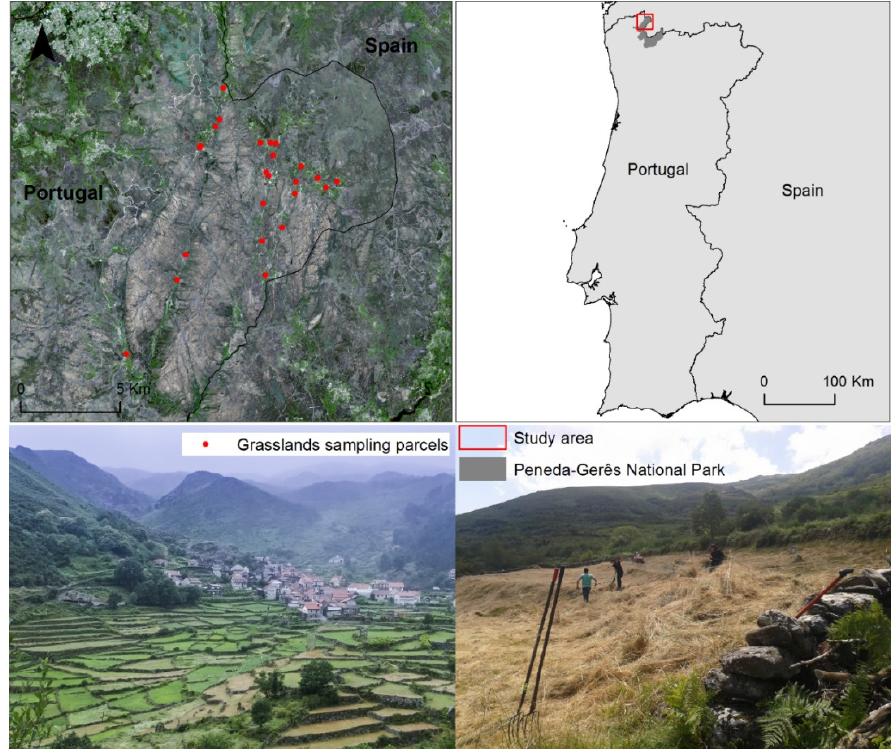
Figure 1. The study area located in the Portuguese Peneda − Gerês National Park, part of the trans- boundary biosphere reserve Gerês − Xurez. The upper left panel shows the study area captured by the Sentinel-2 satellite sensor in April 2016 (red-green-blue composite) and the grassland parcels surveyed for plant species richness (in red, n = 24). The lower panels present grassland mosaics in the study area and the traditional hay cutting performed by local pastoral communities in the summer